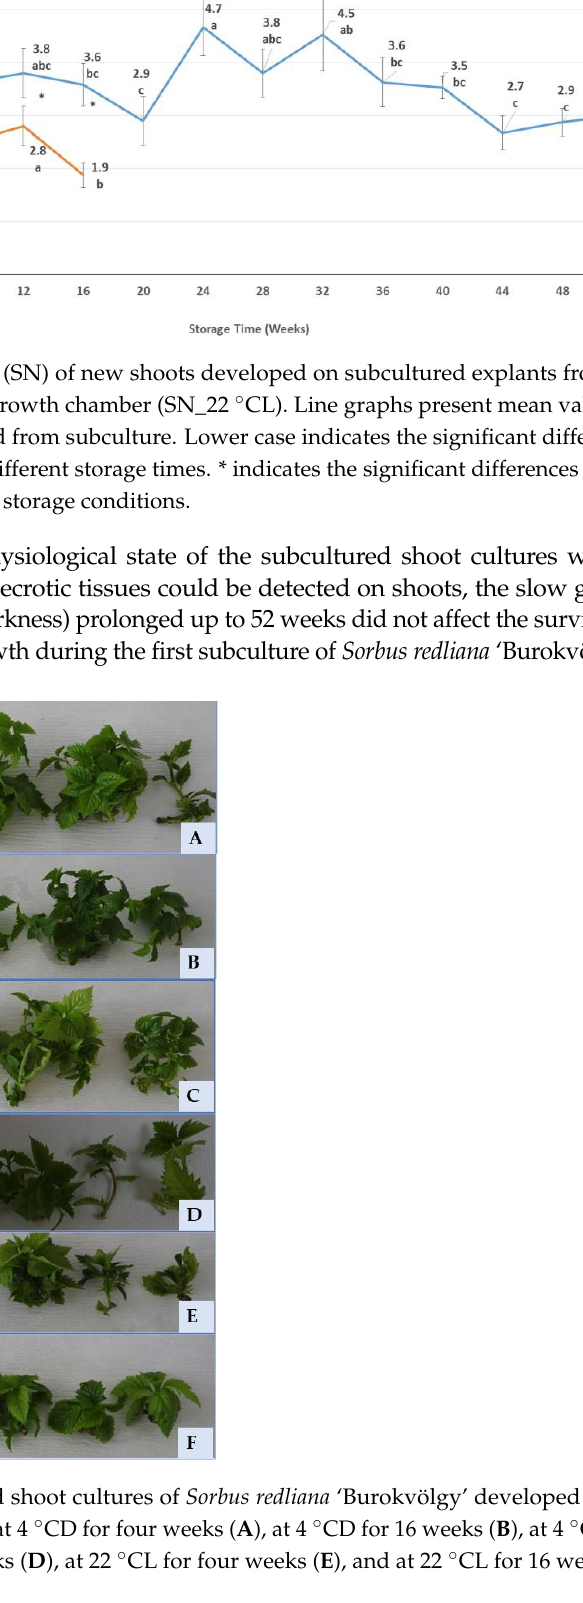
9 of 17 Figure 7. Shoot length (SL) of new shoots developed on subcultured explants from cold storage (SL_4 °CD) and from the growth chamber (SL_22 °CL). Line graphs present mean values ± SE of the SL of new shoots developed from subculture. Lower case indicates the significant differences be- tween the SL measured after different storage times. * indicates the significant differences between the SL measured after different storage conditions. 2.4.2. The number of New Shoots at the End of the Subculture Period In the case of explants from shoot cultures stored at 4 °CD, an increase could be seen after the first four-week storage period, but it was not statistically significant. However,